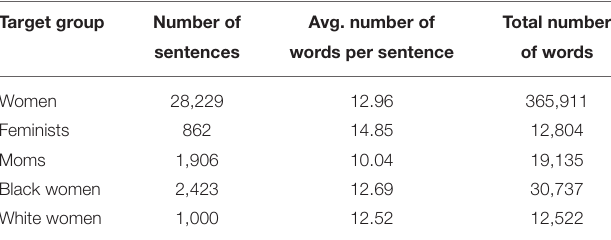
TABLE 5 | The number of extracted sentences with the syntactic pattern “ < target group > are < adjective > ” and the average and total number of words (sequences of alpha-numeric characters) in the sentences for each women-related target